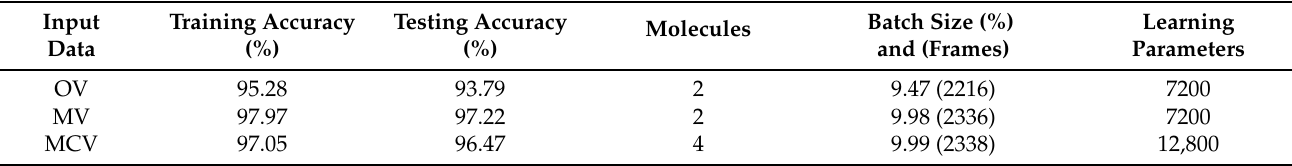
Table 4. Training results for the AHN